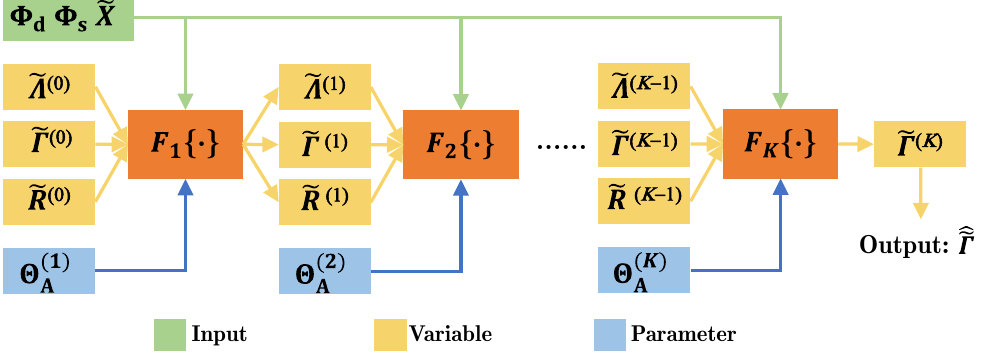
Figure 3. Network structure of 2DMA-Net.